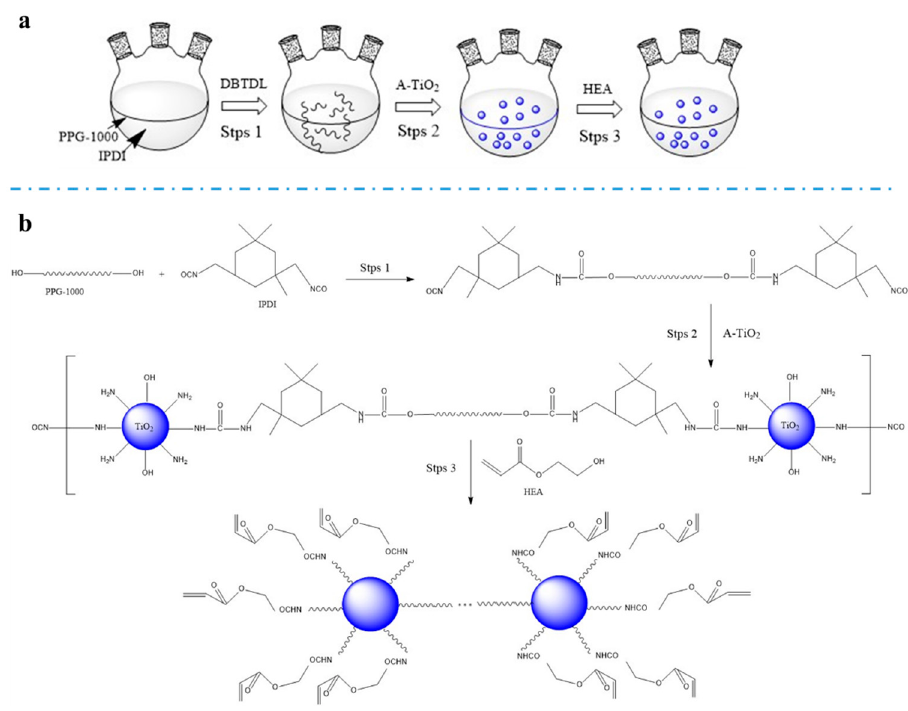
Figure 1. Progress and mechanism for preparation of PU-TiO 2 : ( a ) progress of preparation, ( b ) mech- anism of preparation.